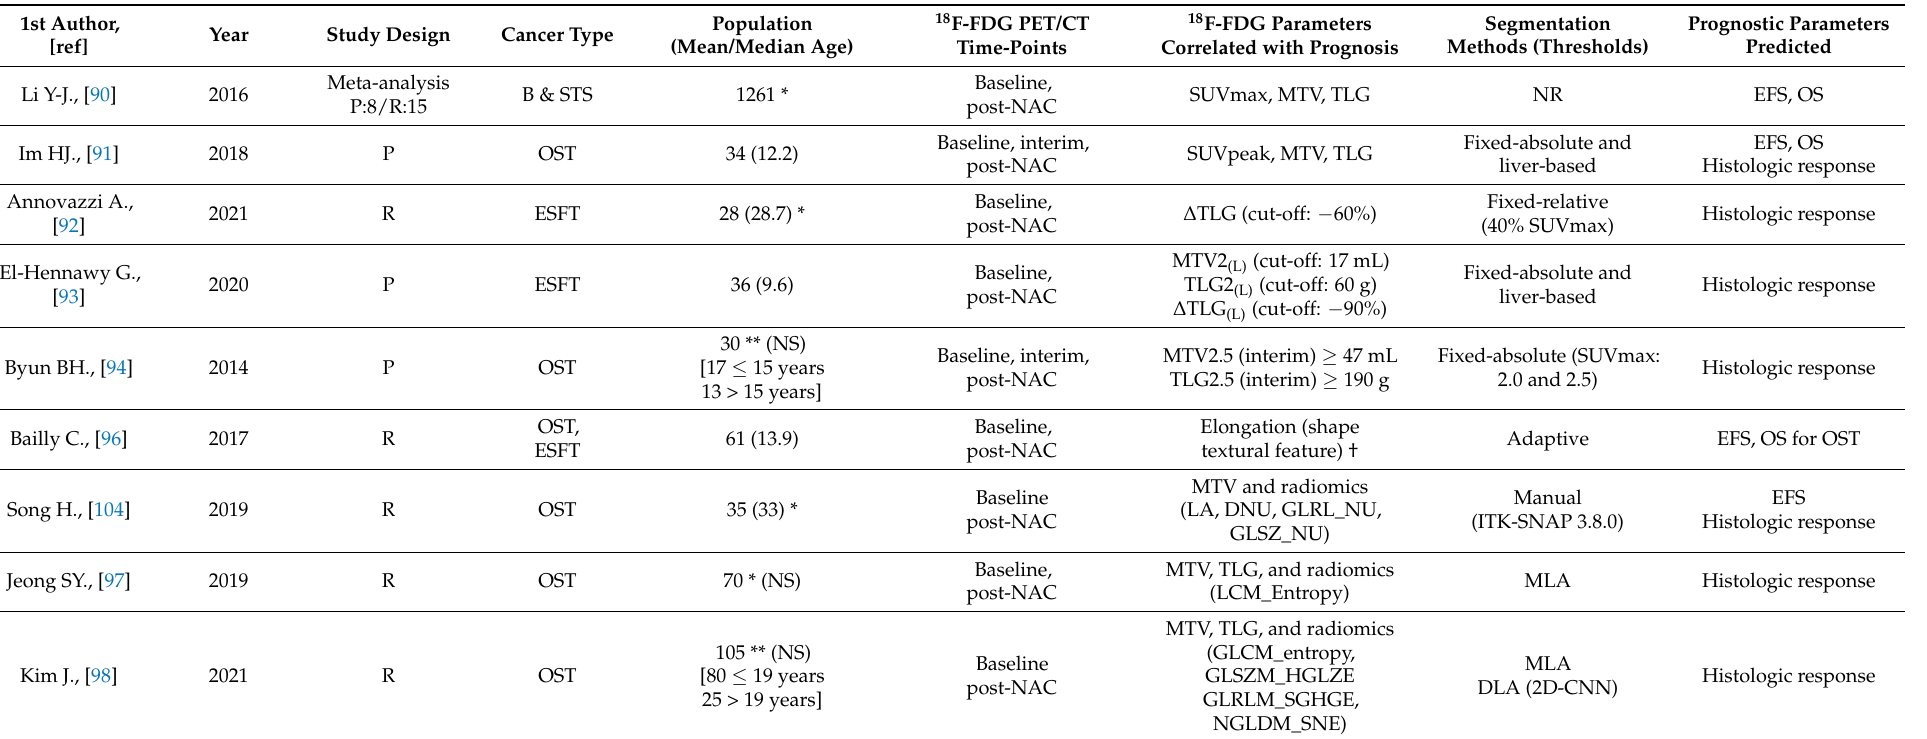
Table 1. Summary of observational 18 F-FDG PET/CT studies, mentioned in the text, including pediatric patients and concerning the predictive value of 18 F-FDG metabolic and radiomic parameters in prevalently localized